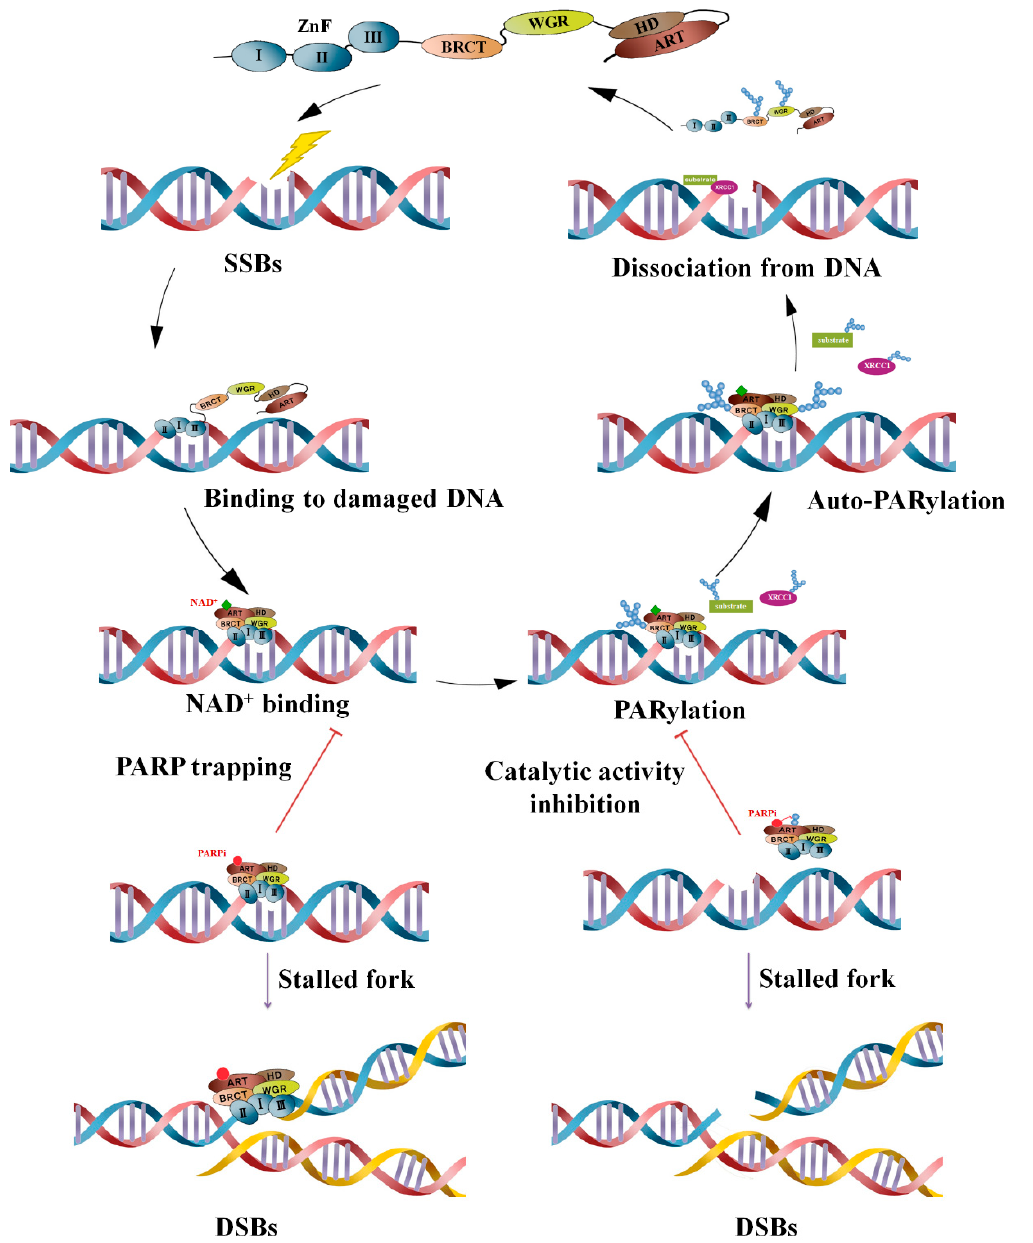
Figure 2. Mechanisms of PARylation and PARP inhibition in the DNA damage response. When a DNA single-strand break occurs, PARP quickly binds to the damage site using a zinc finger domain. It causes recruitment of DNA repair proteins to DNA damage sites by catalyzing PARylation between PARP and its target proteins XRCC1, DNA ligase III, etc., by the ART catalytic domain using NAD+ as a substrate. PARP auto-PARylation then decreases the affinity for DNA, resulting in dissociation from DNA so that the repair protein can bind. At this time, the PARP inhibitor binds to the pocket instead of NAD+, causing PARP to be trapped in the DNA. It encounters a replication fork, causing it to stall, and is converted into double-strand breaks (DSBs) leading to cell death; alternatively, it blocks the recruitment of repair proteins by blocking enzymatic activity where PARP PARylation occurs.